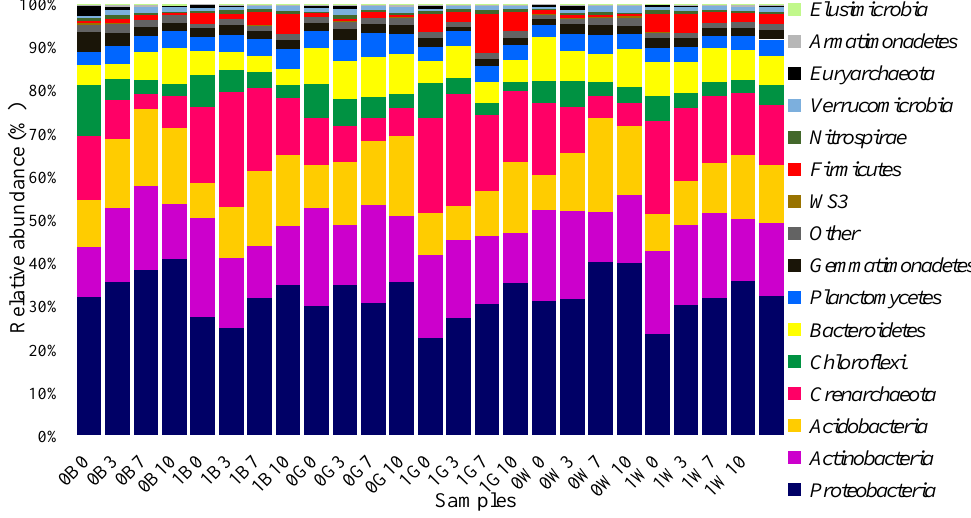
Figure 2. Relative read abundance of dominant bacterial community structure at the phyla level at each site. Relative abundances (>1%) are based on the proportional frequencies of those DNA sequences that could be classified at the phyla level.